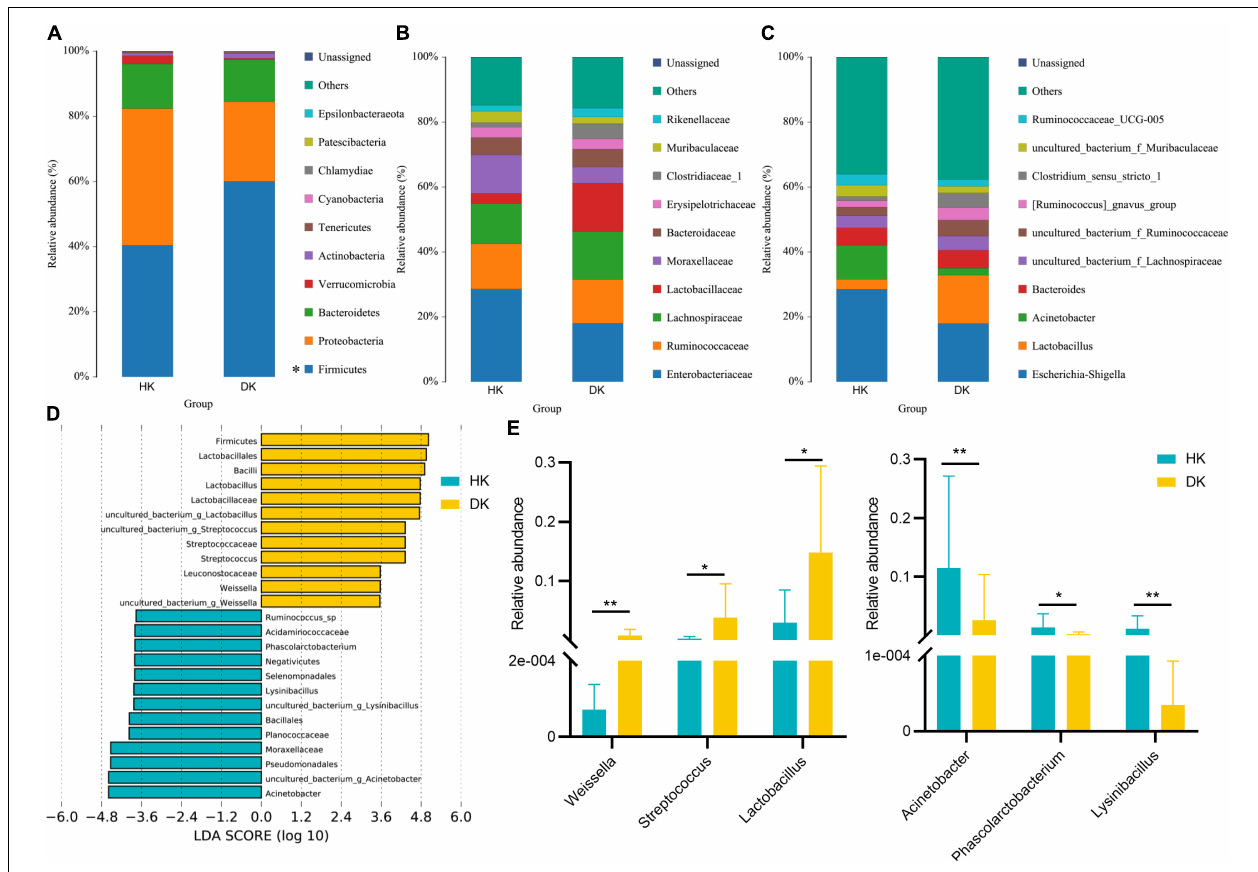
FIGURE 3 | Taxonomic profiles of the fecal bacteria in diarrheic and healthy goat kids from 16S rRNA gene sequencing. (A) Relative abundance of the top 10 phylum. (B) Relative abundance of the top 10 families. (C) Relative abundance of the top 10 genus. A color represents a species, and the block length indicates the relative abundance of the species. Other species are grouped into others as shown in the figure, with unclassified representing species that have not been taxonomic annotated, n = 10. (D) LEfSe bar represents abundant differential taxa in goat kids’ fecal microbiome. The length of the bar chart represents the impact of different species. (E) Different genera in diarrheic and healthy goat kids ( P < 0.05), and data represent mean values ± standard error of mean (SEM), n = 10. * Means P < 0.05, ** means P < 0.01.